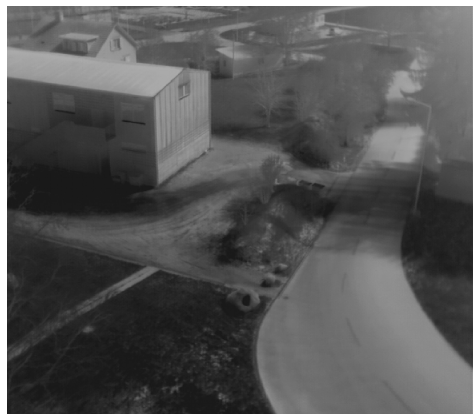
Figure 1: Example for a thermal image acquired by a thermal camera FLIR Tau